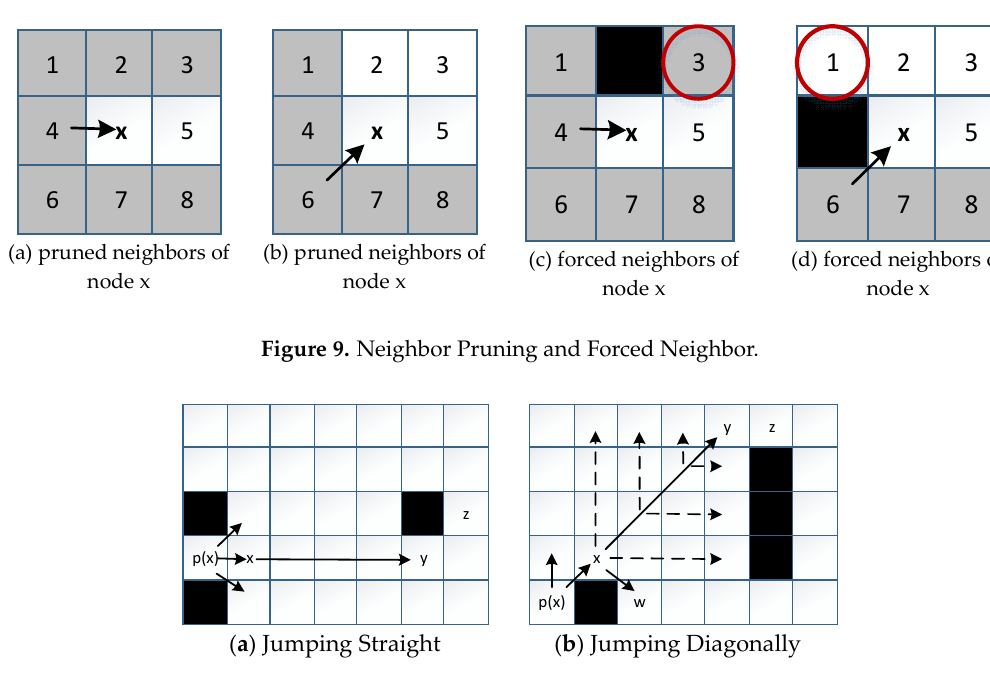
Figure 10 Successful straight and diagonal jumps with the JPS algorithm by applying pruning and forced neighbor rules.